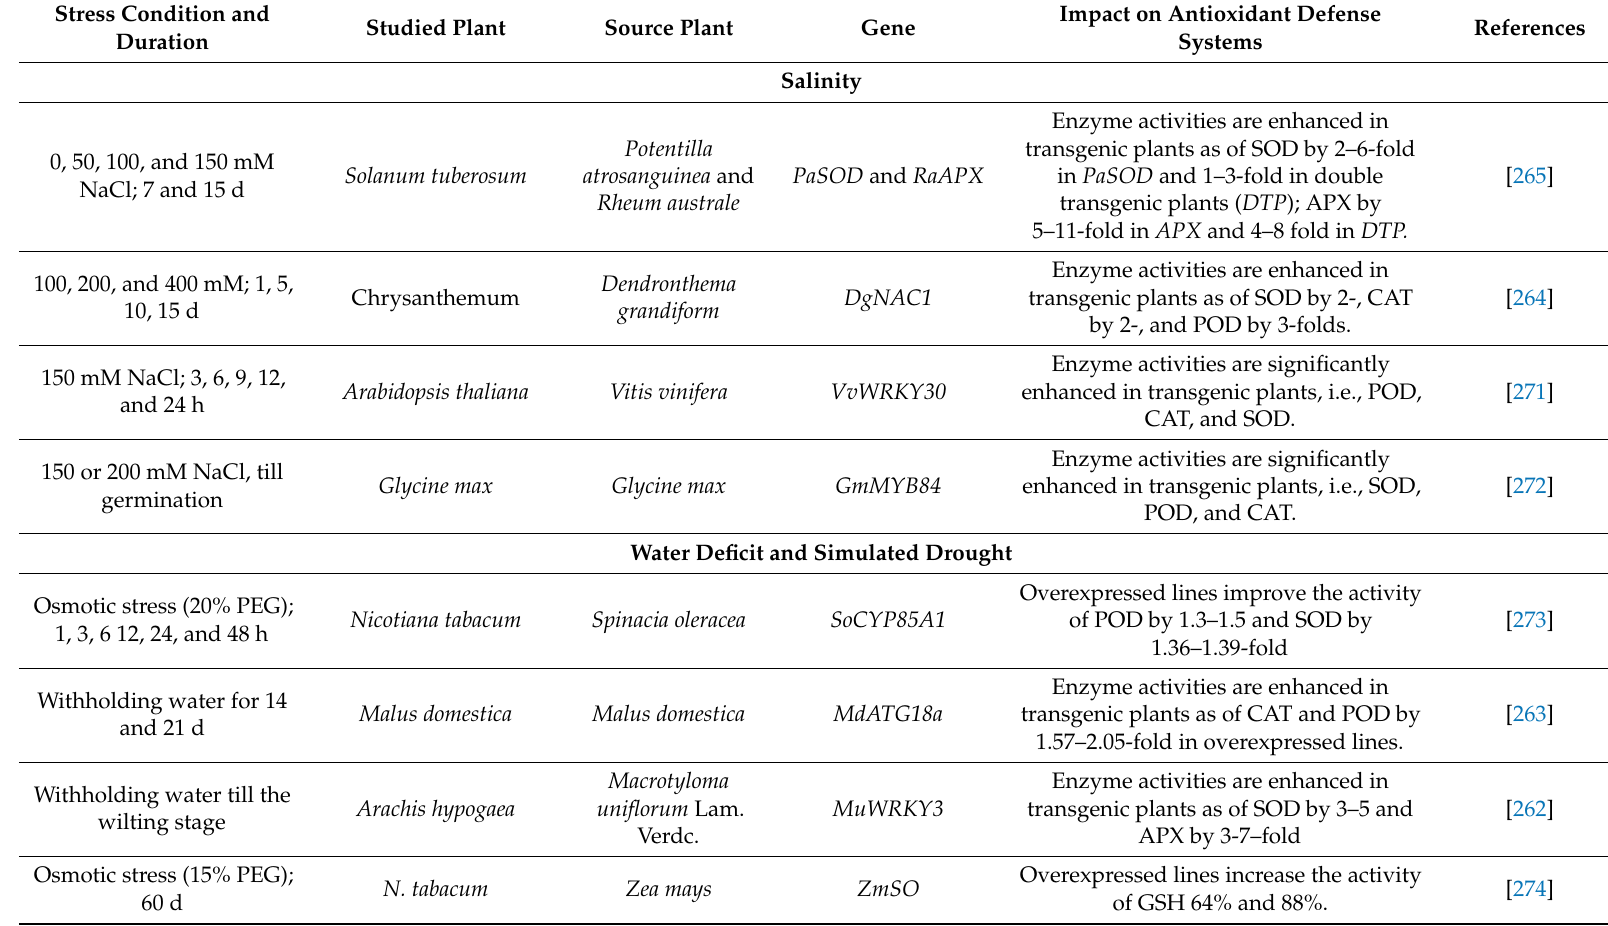
Table 5. Recent advancements in transgenic approaches to enhance the activities of antioxidant defense systems under abiotic stress conditions. Described studies increased stress tolerance by reducing the damage of oxidative stress and by increasing scavenging of ROS under stressful